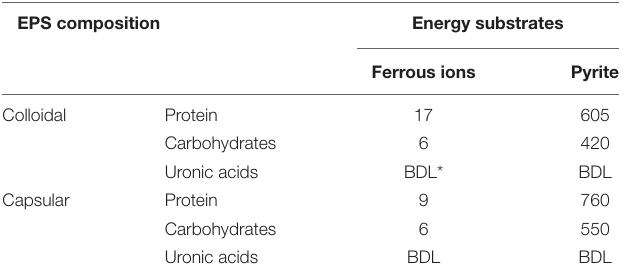
Frontiers in Microbiology |